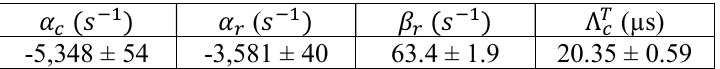
, 𝜶 , 𝜷 , and 𝚲 𝒄𝑻 for the 286.6 ppm 𝒄 𝒓 𝒓